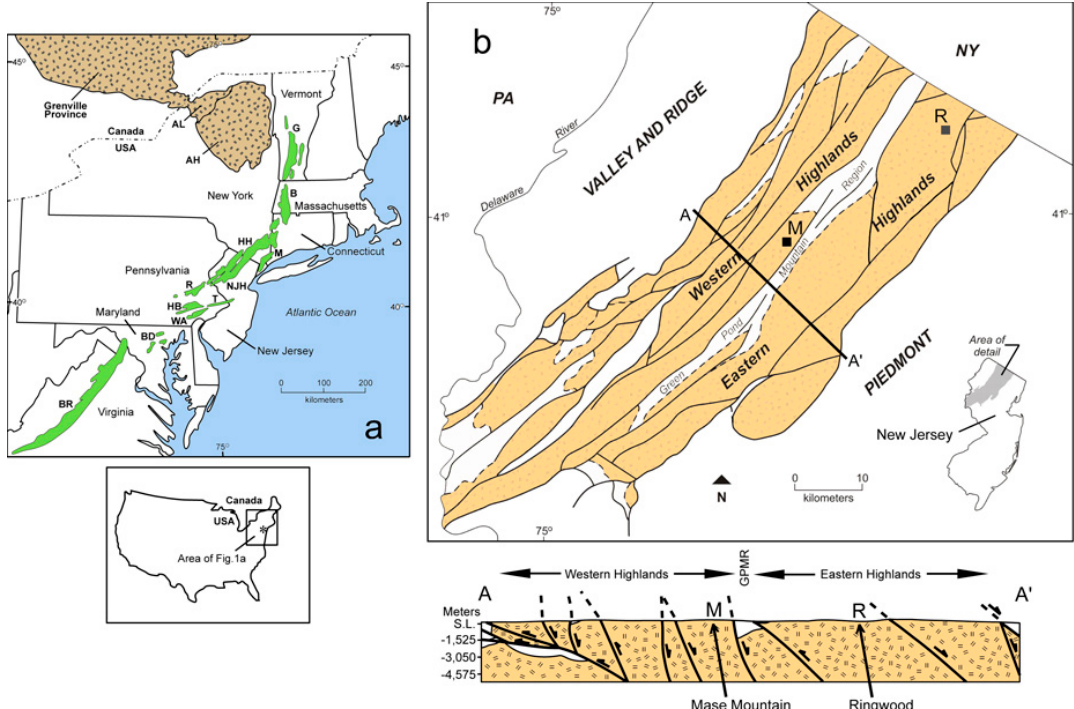
Figure 1. ( a ) Distribution of Grenville-age rocks in central and northern Appalachian inliers (green), the Adirondack Highlands (AH), Lowlands (AL), and the Grenville Province of southeastern Canada (brown). Abbreviations: Vermont Green Mountains (G); Massachusetts Berkshire Mountains (B); New York Hudson Highlands (HH); New Jersey Highlands (H); Trenton Prong (T); Pennsylvania Reading Prong (R); Honey Brook Upland (HB); West Chester and Avondale Massifs (WA); Maryland Baltimore Gneiss domes (BD); and Virginia Blue Ridge (BR). Small map locates area of Grenville rocks in the eastern United States and Canada listed above; asterisk locates New Jersey. ( b ) Simplified geologic map of the Grenvillian New Jersey Highlands (light brown) [8]. Squares locate kornerupine locations at Ringwood (R) and Mase Mountain (M). Kornerupine locations are projected onto line of cross section A–A’ for comparison.